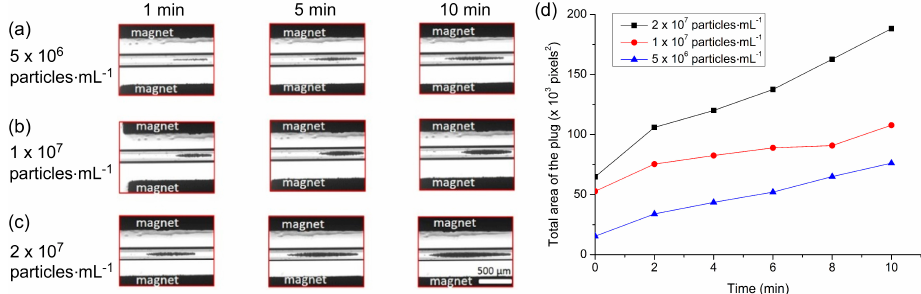
Figure 5. The effect of particle concentration on plug formation. ( a – c ) Photographs of plug formation at time points of 1, 5 and 10 min for particle concentrations of: ( a ) 5 × 10 6 particles·mL − 1 ; ( b ) 1 × 10 7 particles·mL − 1 ; and ( c ) 2 × 10 7 particles·mL − 1 . ( d ) Plot of measured plug sizes over time at the three different particle concentrations. Each pixel was approximately equivalent to an area of 5.6 µm 2 .